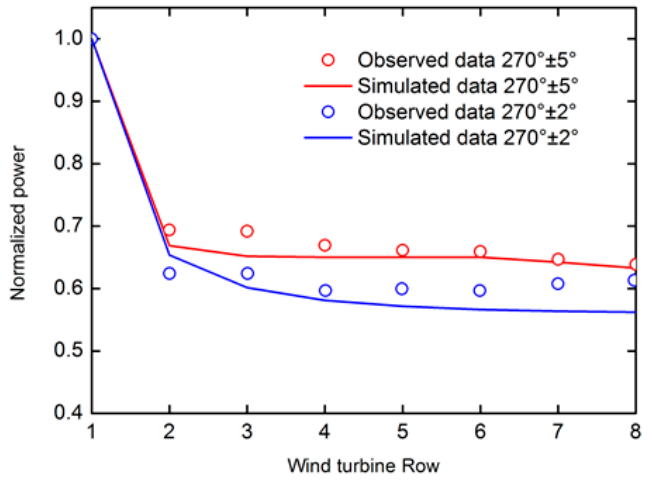
Figure 8. Comparisons of normalized power in the direction of 270°.